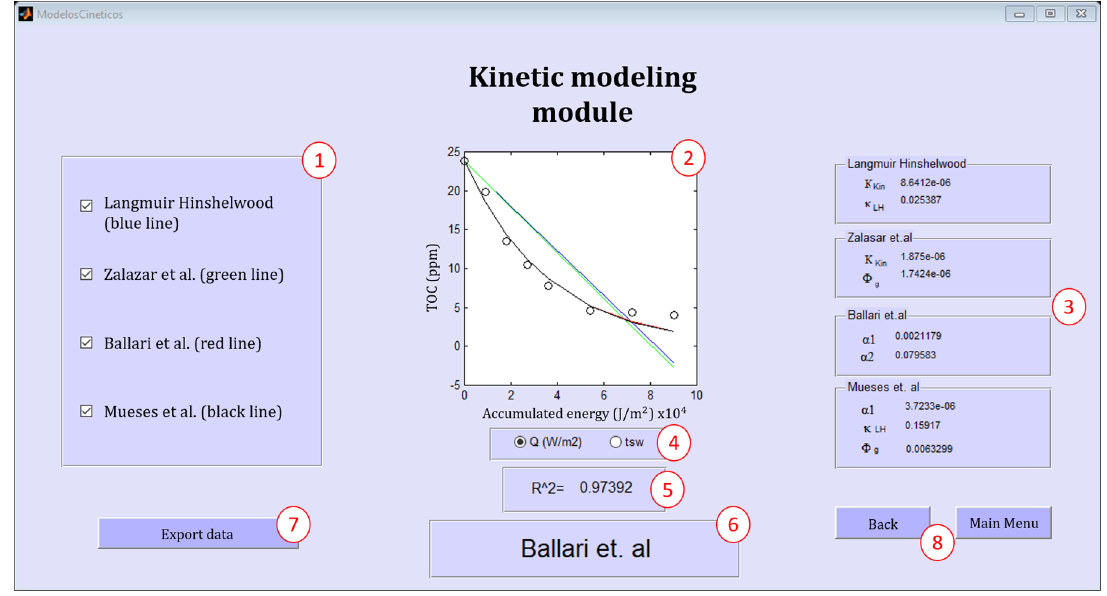
Figure 6. DCA fitting for the available kinetics models in the kinetics modeling module. (1) Kinetic models panel; (2) experimental data and models simulations plot; (3) fitted kinetic parameters panel; (4) x -axis magnitude panel; (5) correlation coefficient panel; (6) display of the kinetic model with the highest R 2 value among the ones selected; (7) export data button; (8) options menu panel.